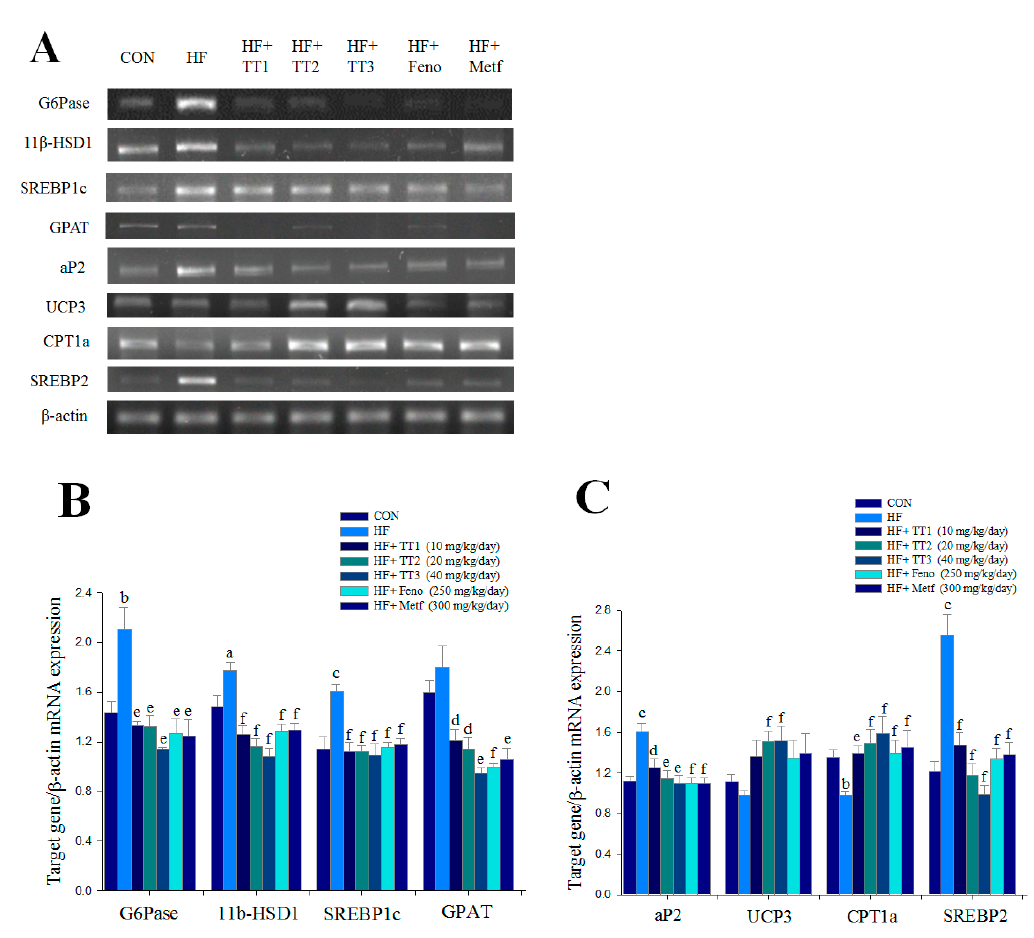
Figure 4. Semiquantative reverse transcription-polymerase chain reaction (RT-PCR) analysis on G6 Pase, 11 β hydroxysteroid dehydrogenase (11 β -HSD1), sterol response element binding protein-1c (SREBP1c), glycerol-3-phosphate acyltransferase (GPAT), adipocyte fatty acid binding protein (aP2), uncoupling protein 3 (UCP3), carnitine palmitoyl transferase Ia (CPT1a), and SREBP2 mRNA levels in liver tissue of the mice by oral gavage dehydroeburicoic acid (TT1, TT2, and TT3, 10, 20 and 40 mg/kg body weight), or fenofibrate (Feno; 250 mg/kg body weight), or metformin (Metf; 300 mg/kg body weight): ( A ) representative image; ( B , C ) quantification of the ratio of target gene to GAPDH mRNA expression. Total RNA (1 µ g) isolated from tissue was reverse transcripted by MMLV-RT; 10 µ L of RT products were used as templates for PCR. The expression levels of G6 Pase, 11 β -HSD1, SREBP1c, GPAT, aP2, UCP3, CPT1a, and SREBP2 mRNA were measured and quantified by image analysis. Values were normalized to β -actin mRNA expression. All values are means ˘ SE ( n = 9). a p < 0.05, b p < 0.01, and c p < 0.001 compared with the control (CON) group; d p < 0.05, e p < 0.01, and f p < 0.001 compared with the high-fat-diet plus vehicle (distilled water) (HF)